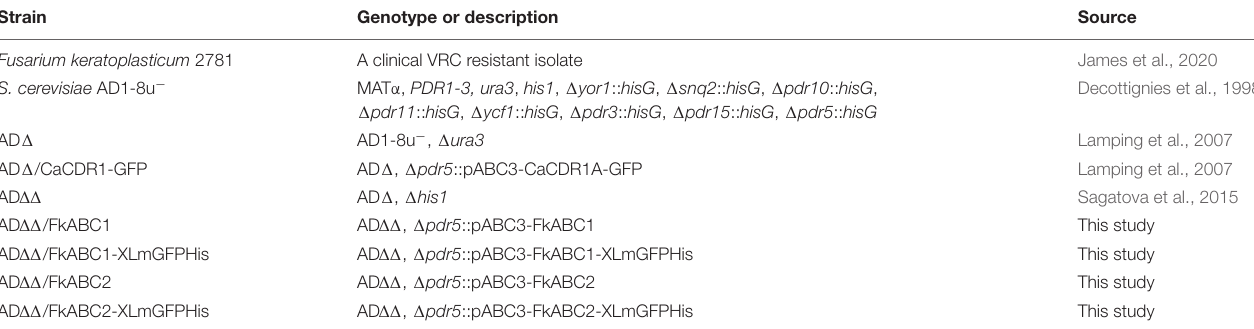
TABLE 1 | Fungal strains used in this